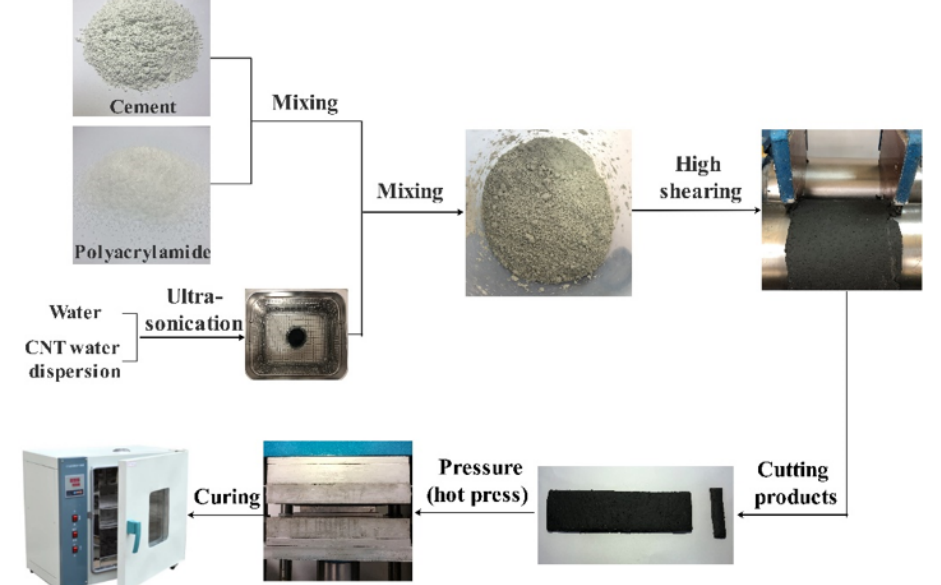
Figure 1: Micro-morphology of CNT and PVA fiber.